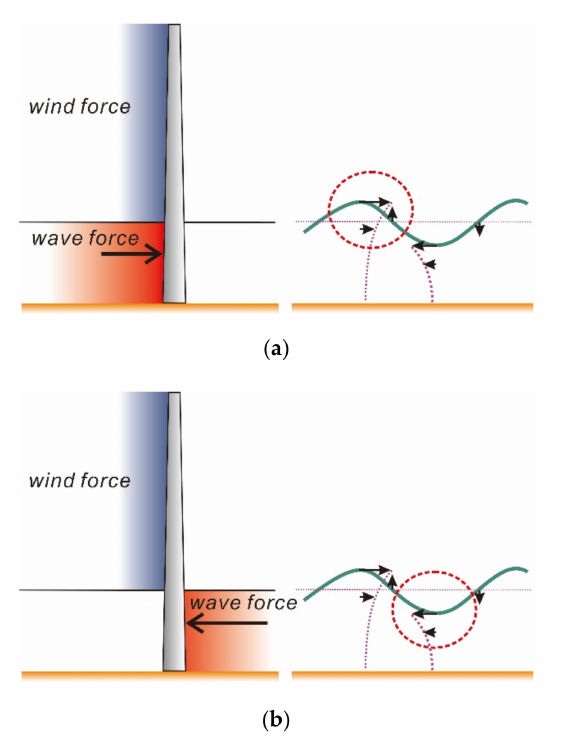
Figure 3. Reversal in the direction of the wave force as the water surface turns into a trough ( a ) wave force in phase with wind force, and ( b ) wave force out of phase with wind